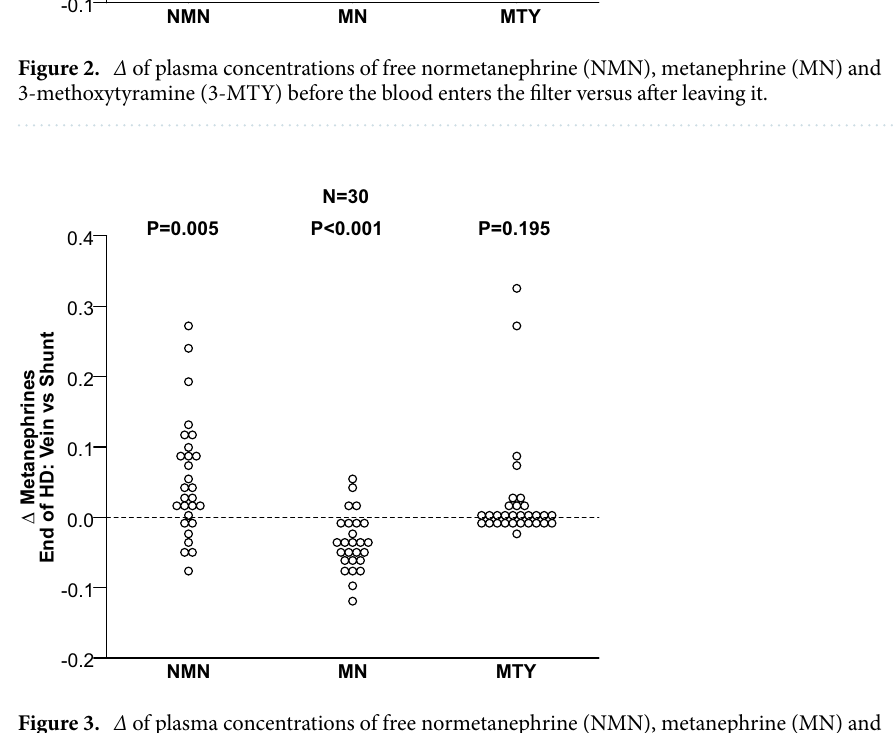
Figure 3. Δ of plasma concentrations of free normetanephrine (NMN), metanephrine (MN) and 3-methoxytyramine (3-MTY) in the venous versus shunt blood, near the end of